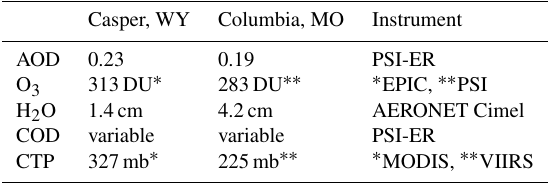
Table 2. Atmospheric properties including aerosol optical depth (AOD) at 550nm, ozone column amount (O 3 ), precipitable wa- ter vapor amount (H 2 O), cloud optical depth (COD) at 550nm, and cloud top pressure (CTP) for the Casper and Columbia sites. Note that precipitable water vapor amounts are from the near- est AERONET stations at St. Louis University, MO (38 ◦ 38.16 (cid:48) N, 90 ◦ 13.9 ◦(cid:48) W), and Spoon Butte, WY (42 ◦ 35.76 (cid:48) N, 104 ◦ 26.58 (cid:48) W), for Columbia and Casper, respectively. (The instruments for O 3 and CTP observations are indicated by symbols ∗ and ∗∗ for Casper and Columbia,